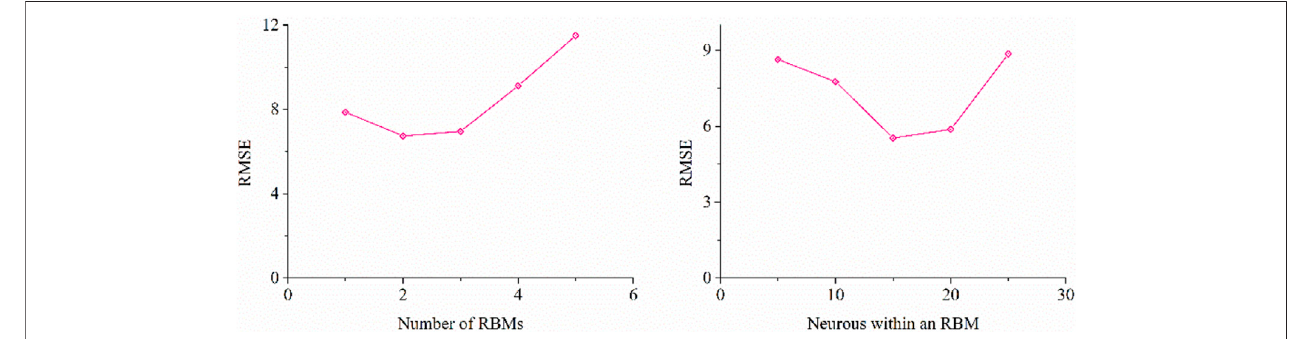
FIGURE 5 | Hyper-parameter tuning process.